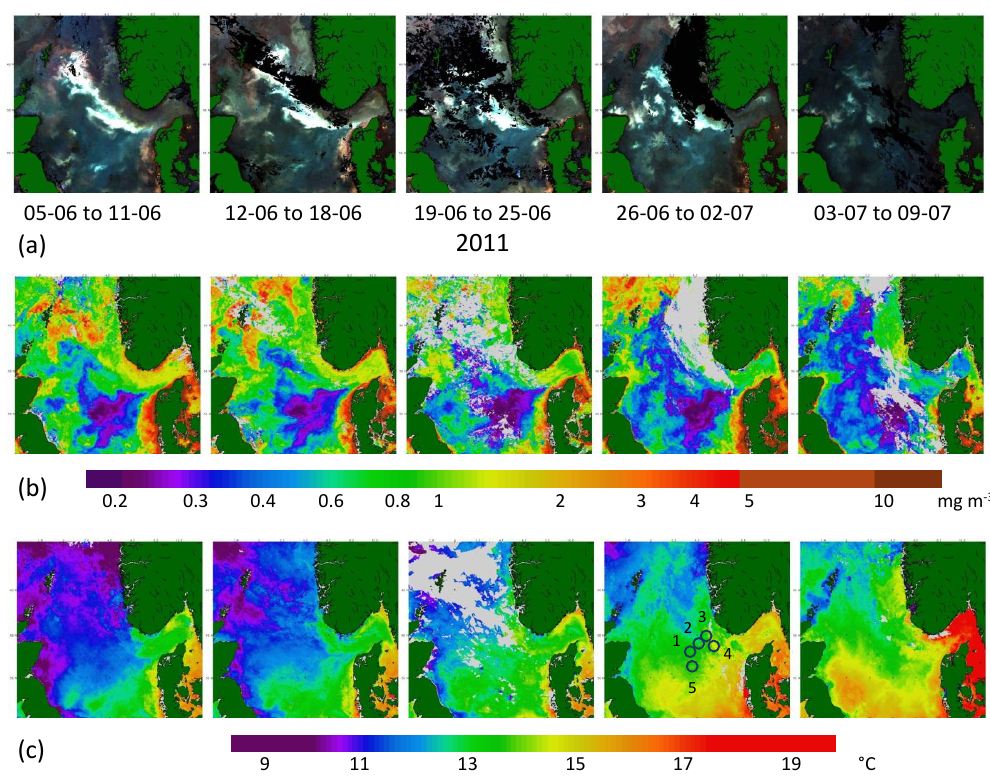
Figure 1. Earth observation 7-day composite data showing Emiliania huxleyi bloom development before, during and after cruise: (a) en- hanced ocean colour from Aqua-MODIS, showing coccoliths as bright patches and persistent cloud in black. (b) Chlorophyll a concentration from Aqua-MODIS, with cloud in light grey. (c) Sea-surface temperature from AVHRR, where numbered circles indicate cruise stations listed in Table